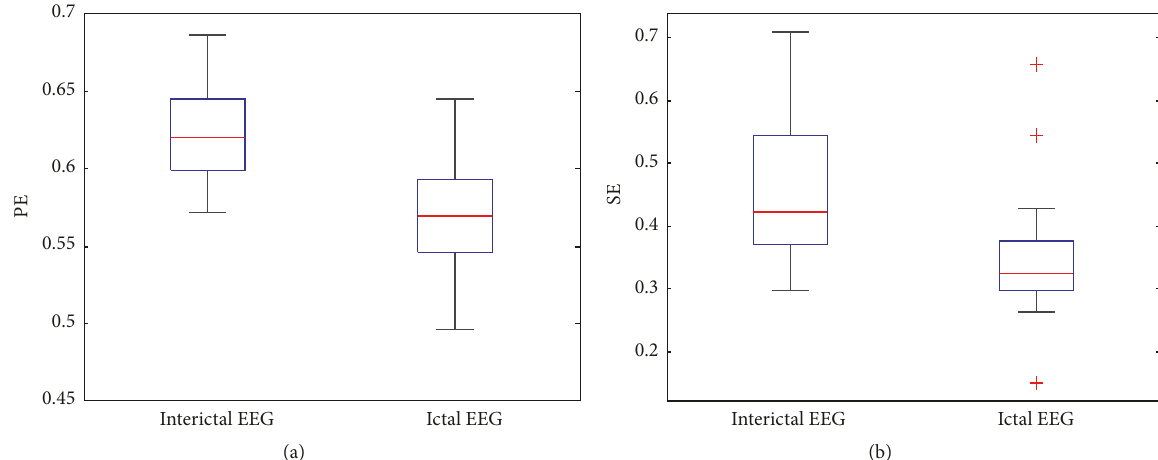
Figure 6: Boxplot of permutation entropy (a) and sample entropy (b) for interictal and ictal EEG on all the 23 patients. On each box, the central mark is the median, the edges of the box are the 25th and 75th percentiles, and the plus signs represent outliers which are more than 1.5 times the interquartile range.